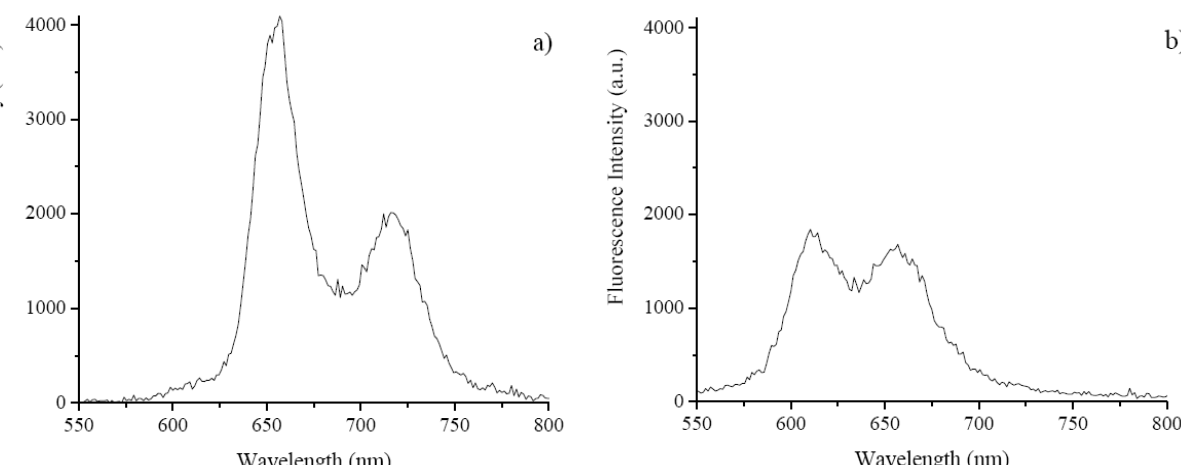
Figure 3. Fluorescence spectra of TCMPOMO ( a ) and Zn(II)TCMPOMO ( b ) in chloroform.